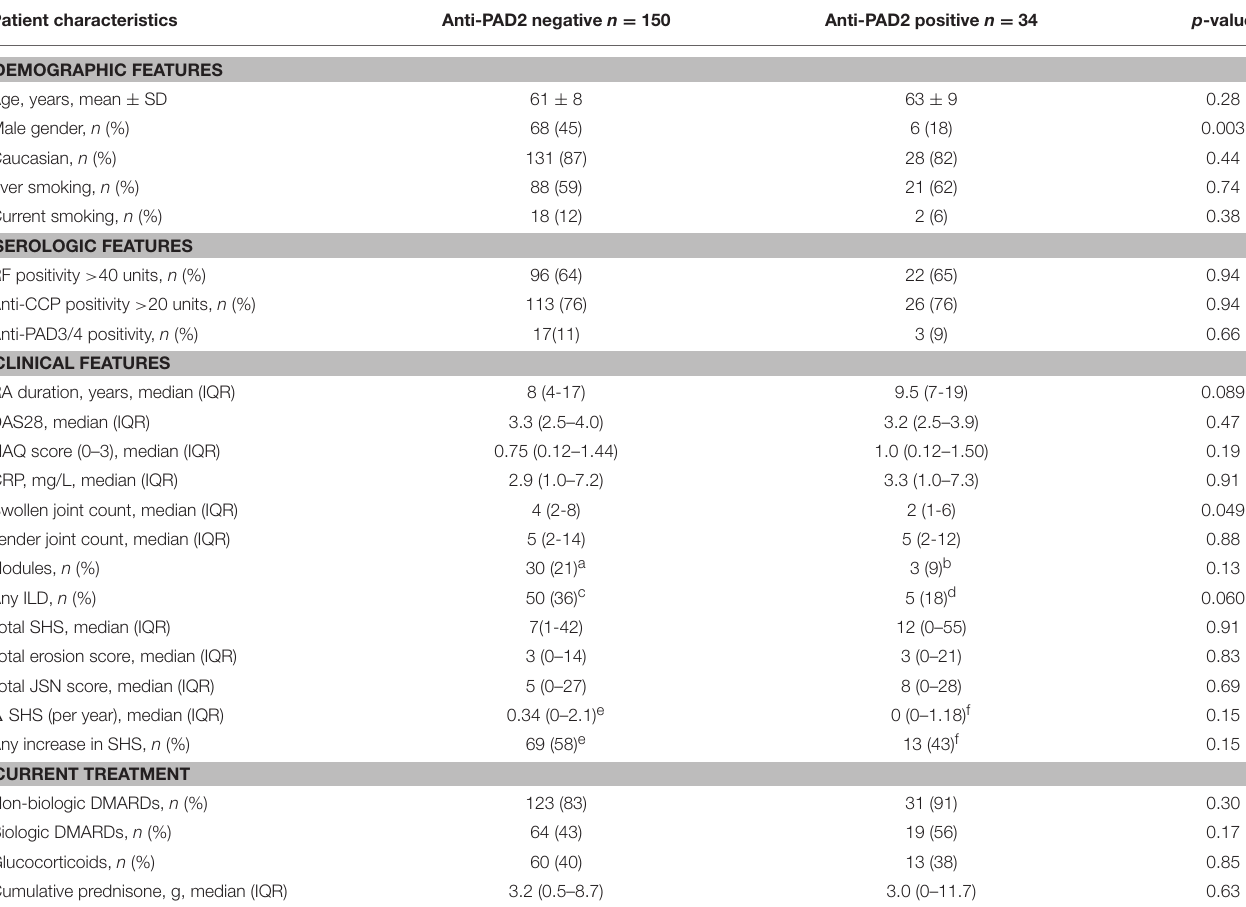
TABLE 1 | Characteristics of ESCAPE RA patients according to anti-PAD2 antibody